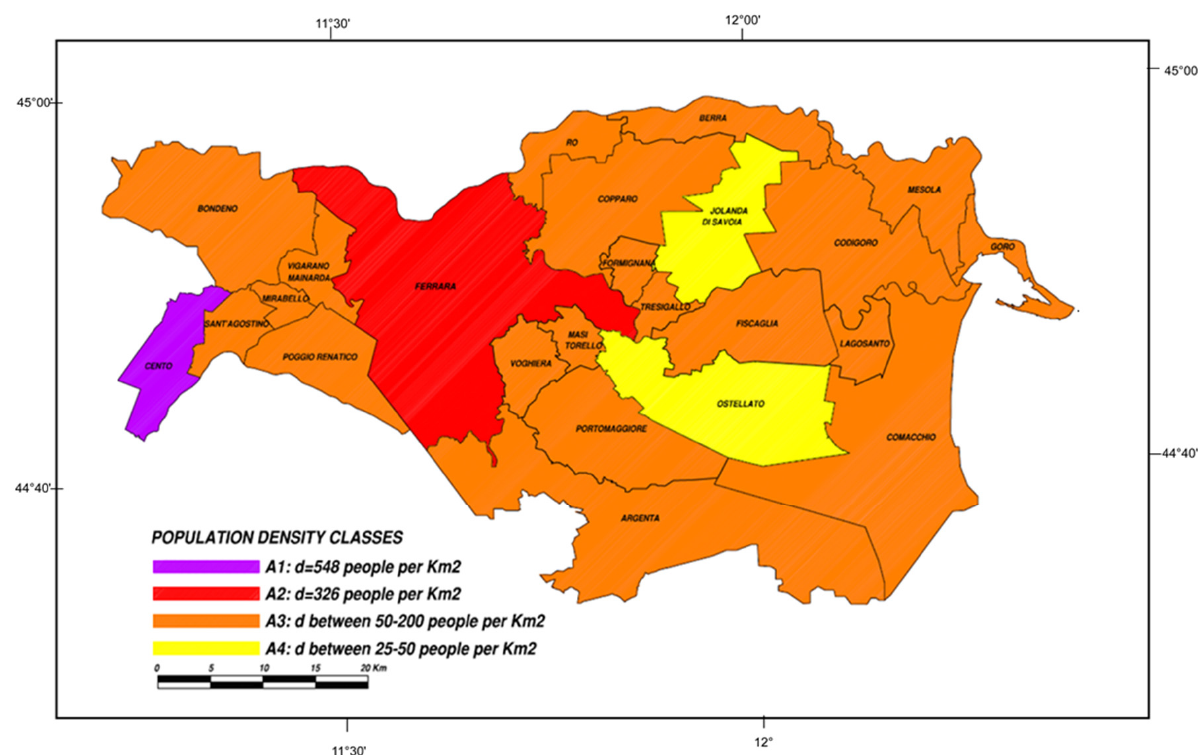
Figure 7. Map of the population density for the province of Ferrara.